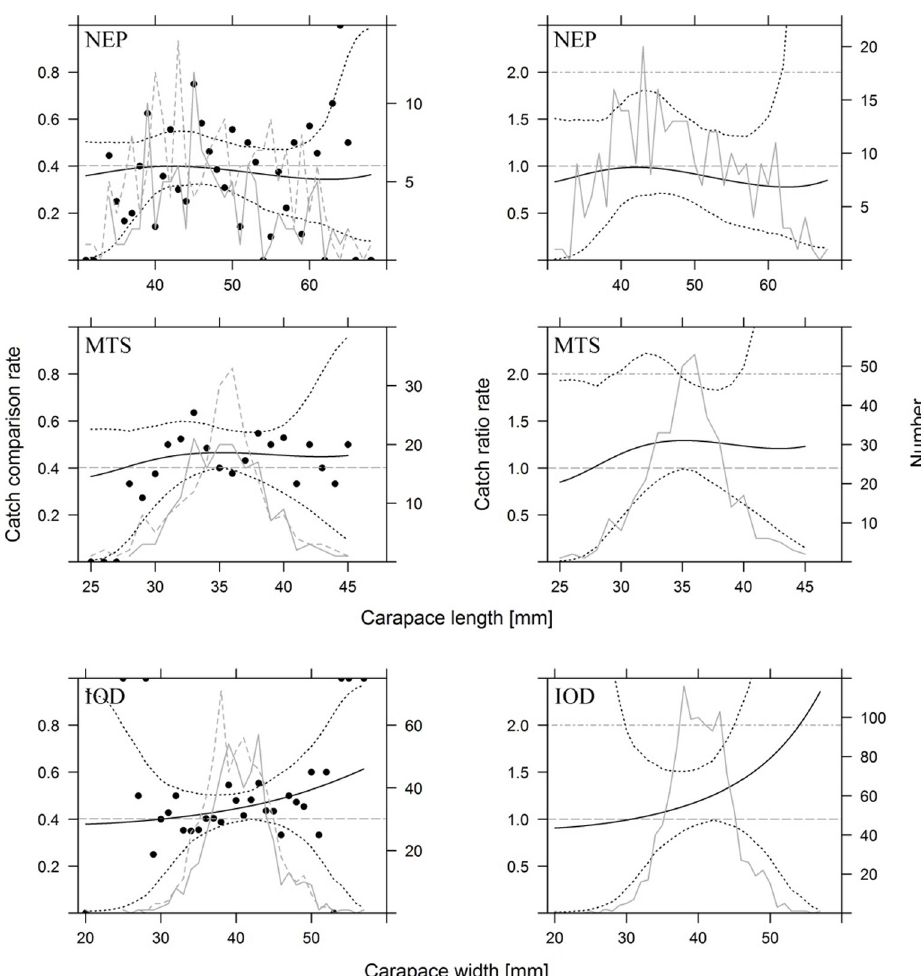
Fig. 4. Catch comparison rate (left column) and catch ratio rate (right column) for the longline deployments with one and two days soaking time (solid black curves) for crustacean species. Dots represent the experimental rates. Thin black dotted curves represent the 95% CI for the catch comparison curves. Dark grey solid curves (left column) represent summed and raised catch populations for deployments with two day soaking time. Dark grey dashed curves (left column) represent summed and raised catch population for deployments with one day soaking time. Dark grey dashed curves (right column) represent total summed and raised catch population for both deployments with one and two day soaking time. Horizontal dark grey dashed lines represent baselines for no effect of soaking time on the catch performance. Horizontal dark grey dot-dashed line represents line where longlines soaked for two days are catching twice as much as longlines soaked for one day. Performance is proportional to soaking time. NEP: Norway lobster; MTS: mantis shrimp; IOD: blue-leg swimming